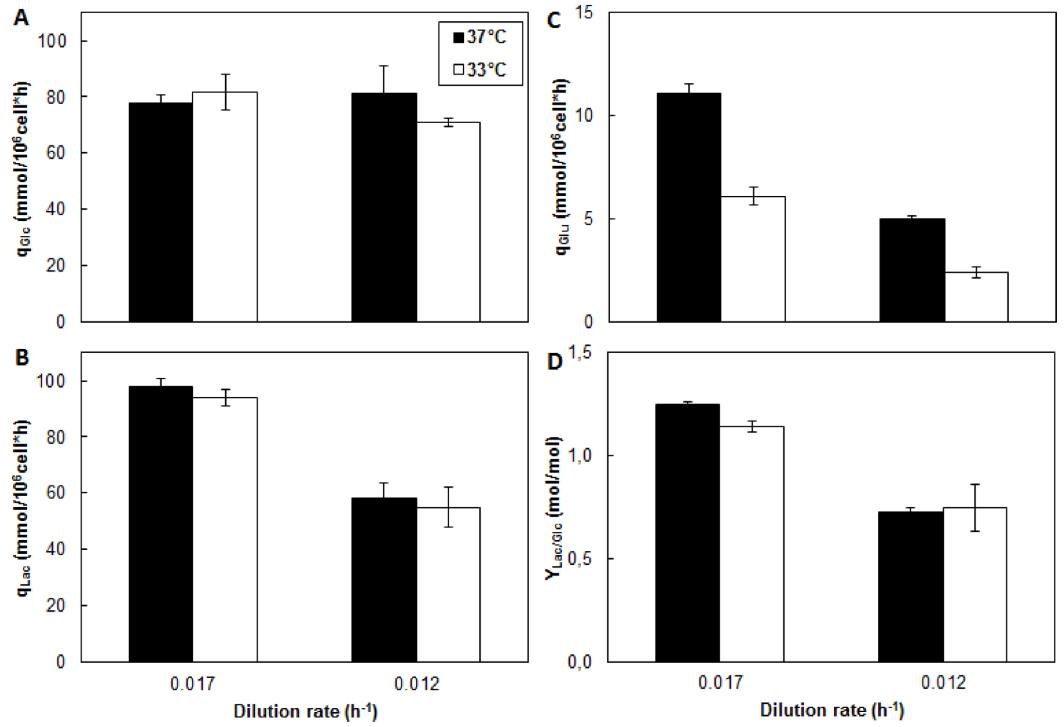
Figure 4. Metabolic behavior of CHO cells growing at different culture temperatures and dilution rates. A: Specific rate of glucose consumption. B: Specific rate of lactate consumption. C: Specific rate of glutamate consumption. D: Lactate yield from glucose. & Condition 37 u C; % Condition 33 u C.